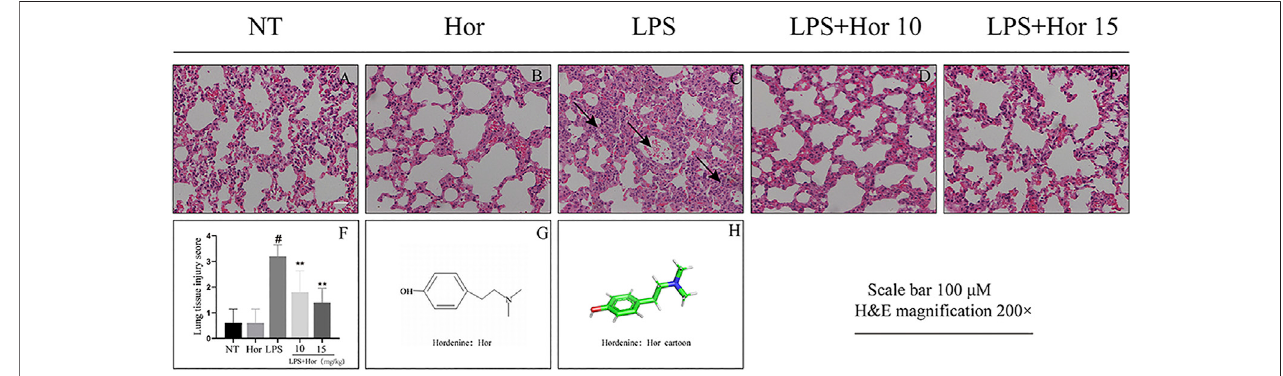
FIGURE1| Hordenine(Hor)alleviateslungpathologicaldamageinLPS-inducedacutelunginjury(ALI).AfterintraperitonealinjectionofHor(5and10 mg/kg)at1 h before modeling, an acute lung injury model was established using nasal drops. Lung tissue was collected at 24 h after LPS stimulation. Tissue sections were stained withhematoxylin andeosin(H andE). (A – E) Hand Estainingresultsofthelung tissue inmice (arrowsrepresent the lesionarea). (F) Lunghistopathologicalinjury scores. (G) Hormolecularstructure. (H) Three-dimensionalmodeloftheHormolecularstructure.Resultsareshownasmeans ± SD( n (cid:1) 3).# p < 0.01vs.notreatment(NT) group; pp p < 0.01 vs. LPS group. Hor: hordenine; LPS: